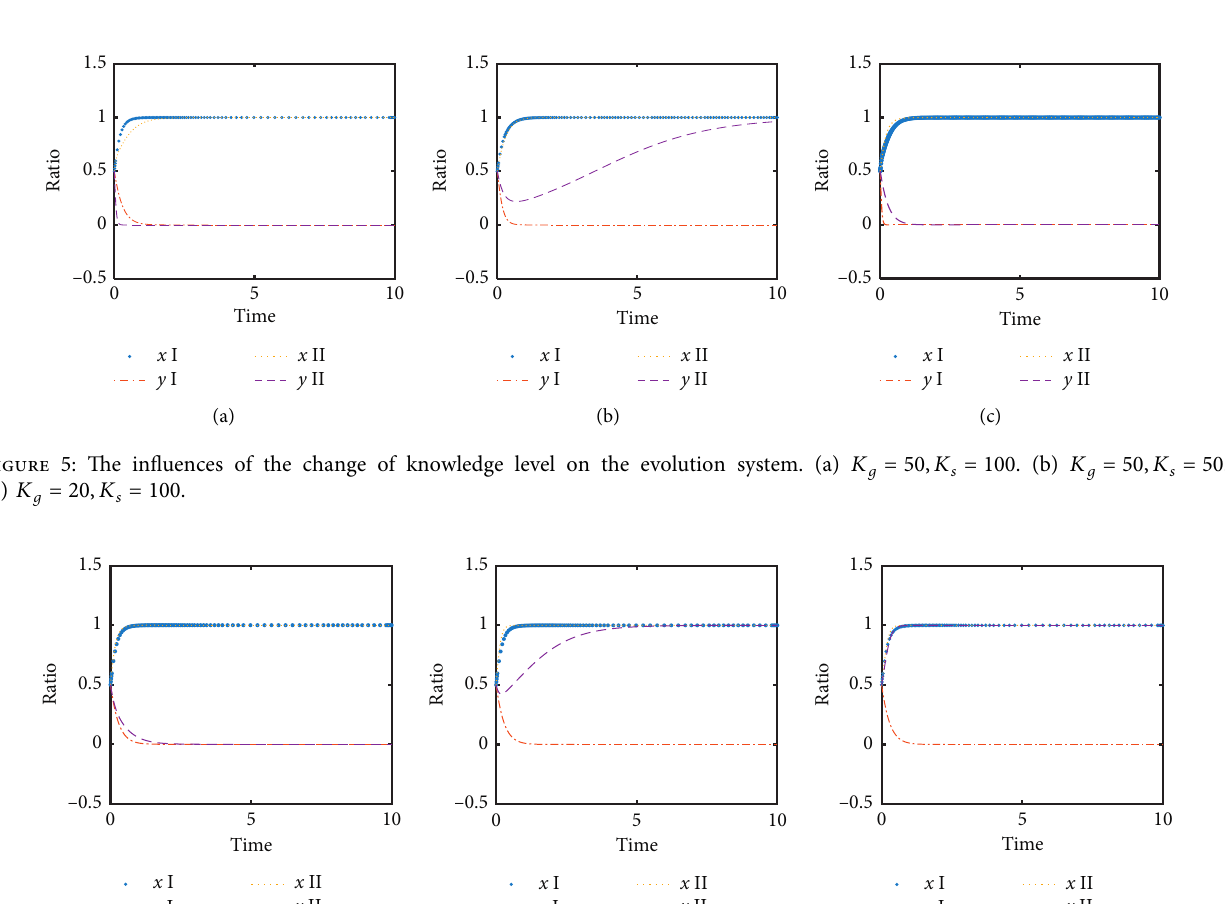
Figure 6: The influences of the change of the degree of complementary knowledge on the evolution system. (a) σ � 0 . 8. (b) σ � 1. (c) σ � 1 . 5.